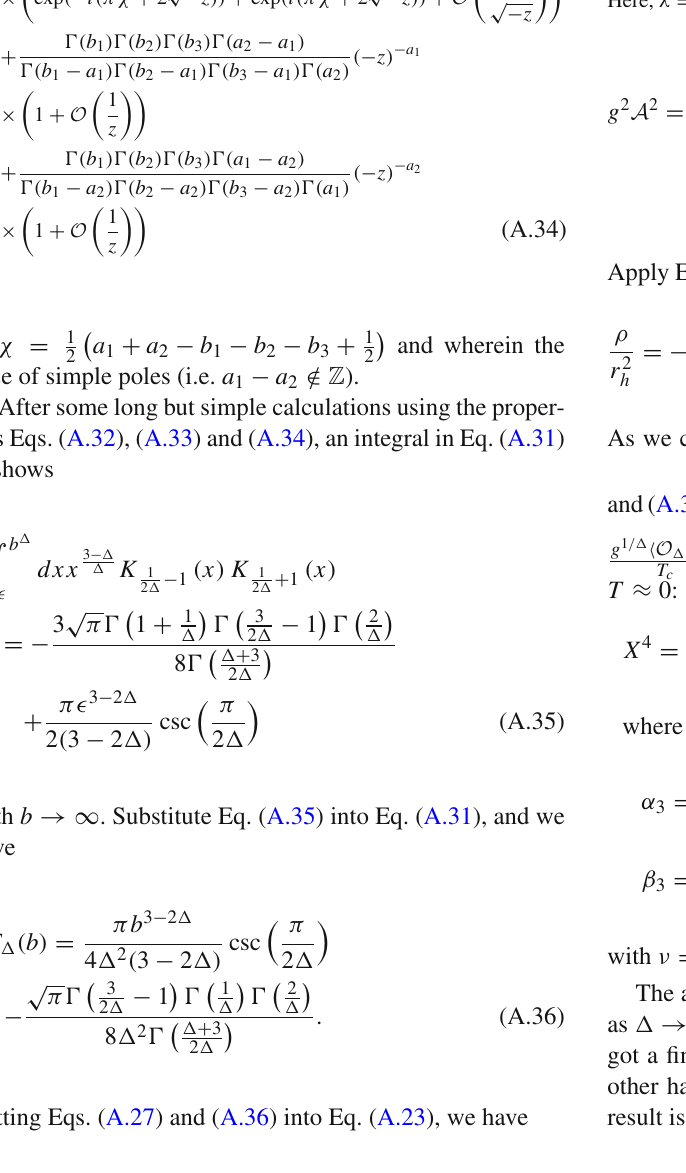
Fig. 14 ResultofRef.[7]:Thecondensateasafunctionoftemperature. Here, λ =